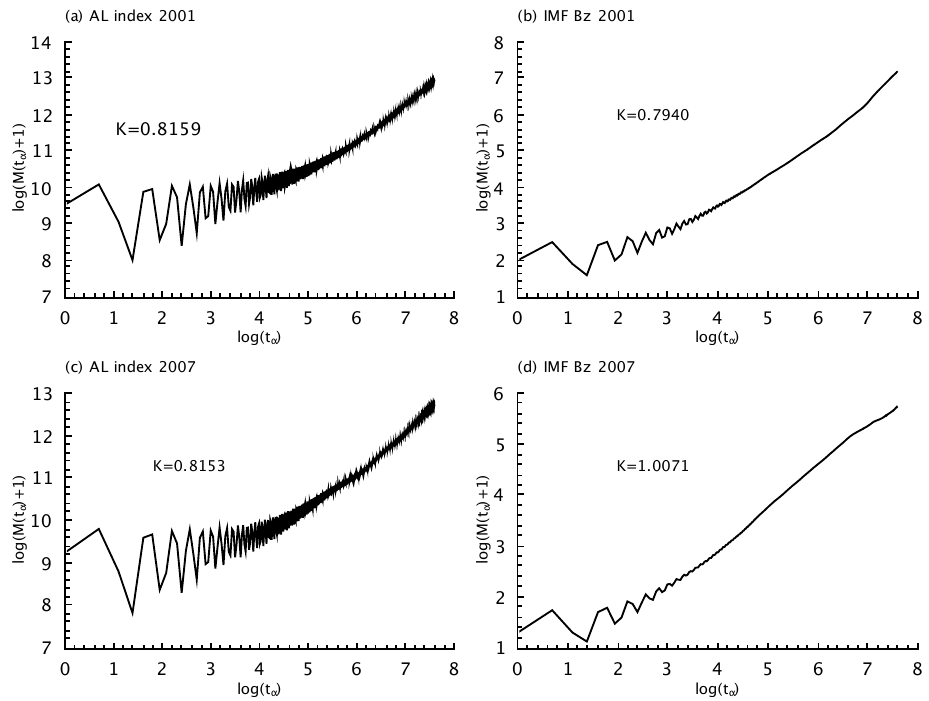
Fig. 3. The computation of K values from the log (M(t α ) + 1 ) vs. log (t α ) plots from the 5-min averaged AL index and IMF B z during July–September 2001 and 2007, using N = 20000 data points. The slopes of the curves converge well, yielding the K values. The cases for the other epochs have similar features.